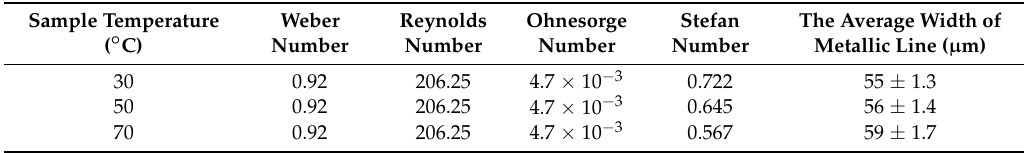
Table 3. Comparison of sample conditions based on the results of the experiment and related calculation formula.